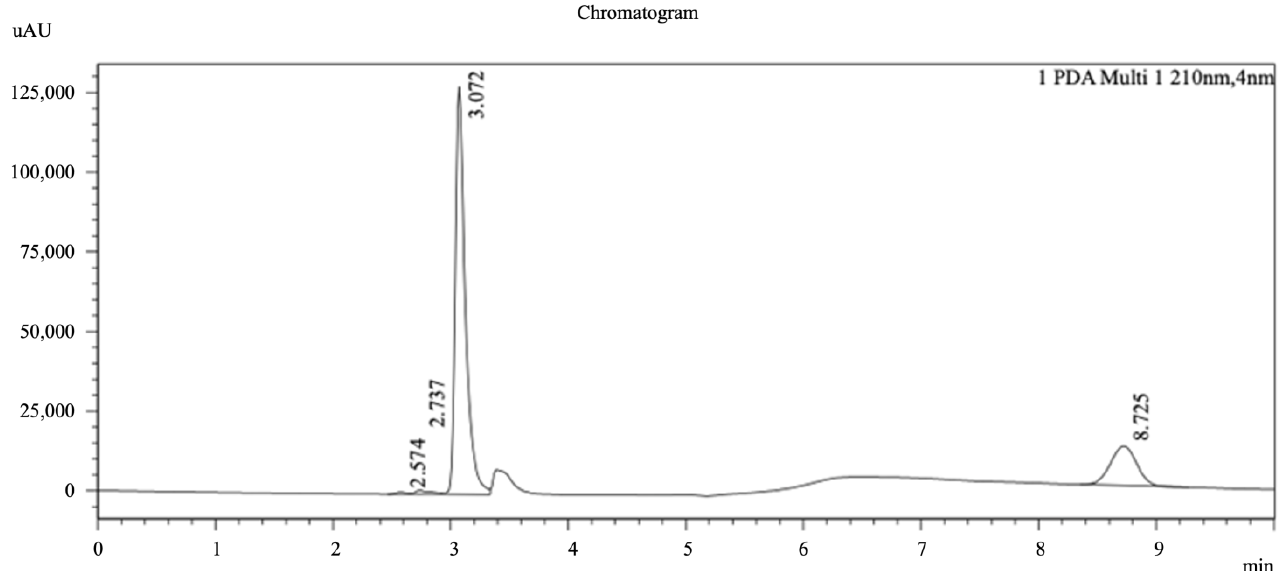
Figure 2. Representative HPLC photo-diode array (PDA) chromatogram of malanto extracts. Conditions: mobile phase acetonitrile: water (65:35, v/v) ; flow rate 0.9 mL/min; PDA detection wavelength 220 nm; column temperature 30 °C; sample temperature 25 °C; injection volume 20 µL.